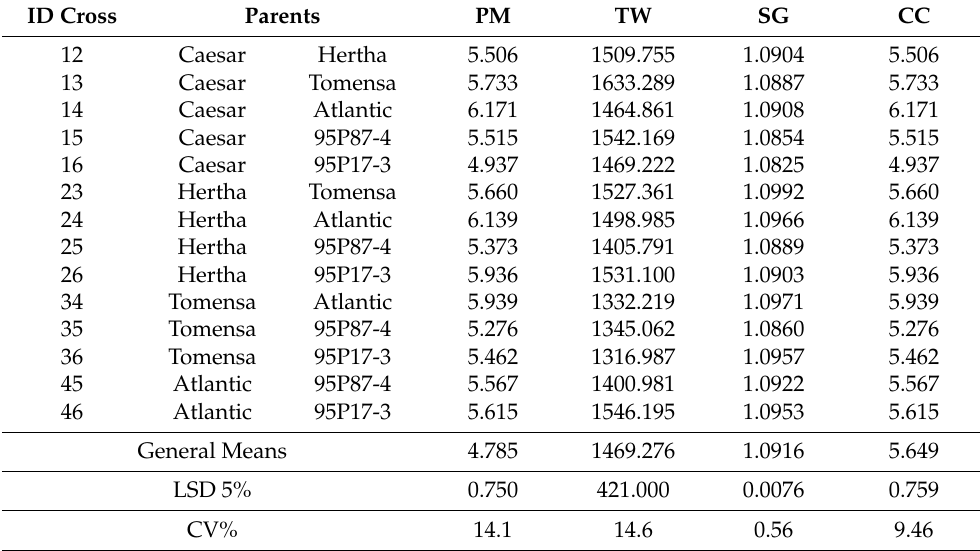
The SCA estimates for CC also showed a significant negative estimate for the cross Caesar × 95P17-3; however, this result must be nuanced due to the presence of the signifi- cant interaction of SCA by site. No other crosses showed a significant SCA effect for CC, as expected from the influence of environmental effects, but the best positive SCA estimates were for crosses as Caesar × Atlantic or Hertha × 95P17-3. As for GCA, the genetic effects observed for the trait in crosses are affected by where the crop is grown. Mean values, coefficients of variation (CV%), and least significant differences (LSDs 5%) of the progenies evaluated across three locations are presented on Table 10. Table 10. Mean values, least significant differences (LSDs 5%) and coefficients of variation (CV%) for agronomic and quality traits of